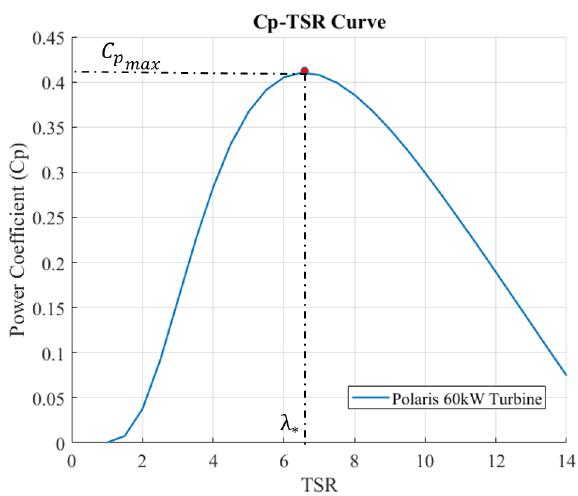
Figure 5. Power coefficient curve of a 60 kW wind